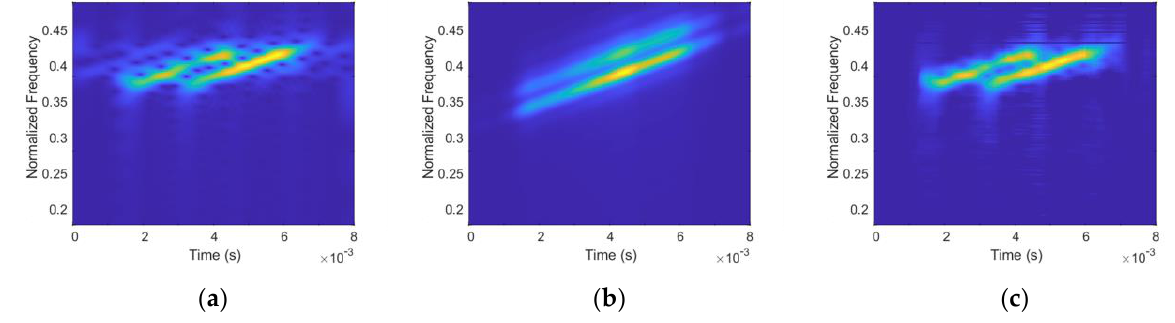
Figure 7. Reverberation suppression results for the signal with two highlights: ( a ) input signal; ( b ) output of the NMF method; ( c ) output of ACANet.